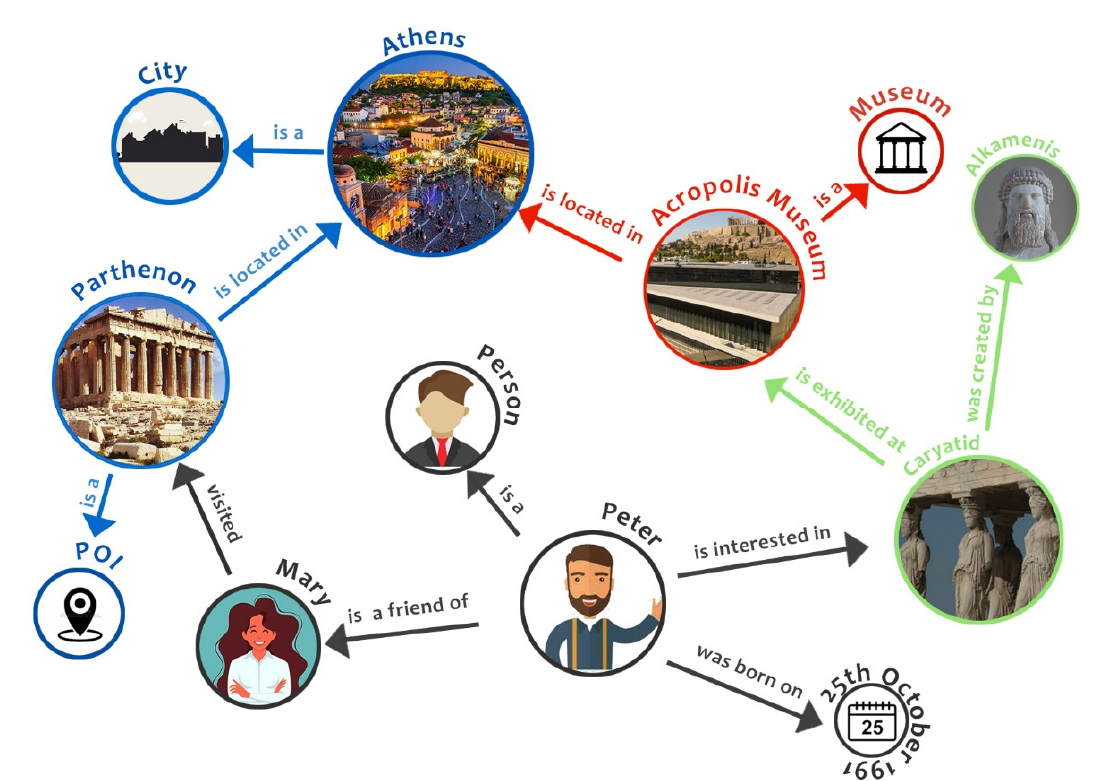
Figure 3. An example knowledge graph representing knowledge about the Acropolis and related entities, e.g., museums, visitors.